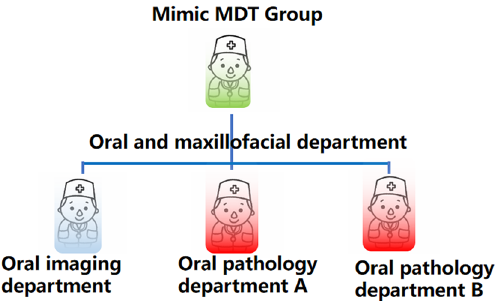
Figure 2. Grouping in the Mimic MDT training including a oral surgeon,a oral radiologist and one or two oral pathologist. Photoshop CS5 software is used to generate cartoon drawing in Fig. 2(ADOBE * PHOTOSHOP * CS5 EXTENDED12.0 × 32 version http:// www. adobe. com/ cn).